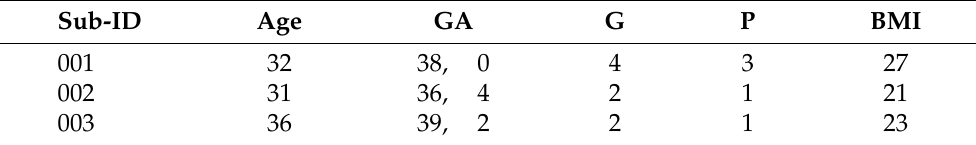
Table 1. Characteristics of the women involved in the trial (DS-R). GA = gestational age (weeks, days); G = gravida; P = para; BMI = body mass